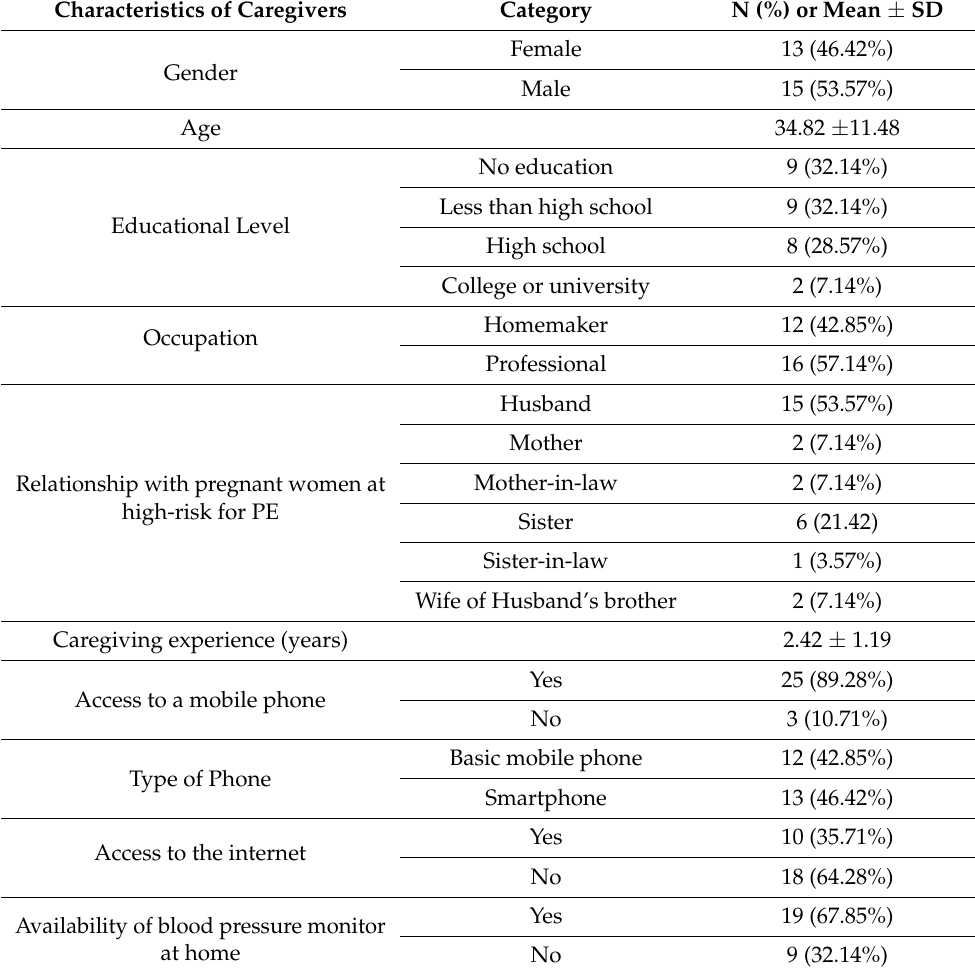
Table 2. Characteristics of caregivers (n =